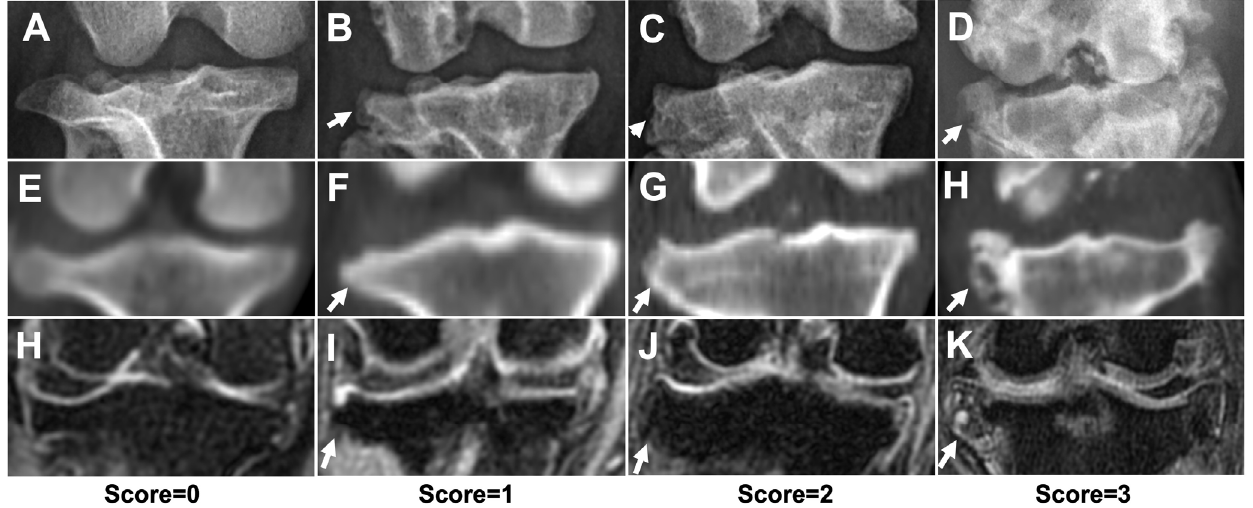
Figure 5. The severity of osteophytes/enthesophytes of stifle joint using different imaging modalities. Representative DR ( A – D ), CT ( E – H ), and MRI ( H – K ) images, with score = 0 ( A , E , H ), score = 1 ( B , F , I ), score = 2 ( C , G , J ), and score = 3 ( D , H , K ). White arrows indicated osteophytes/enthesophytes formation at lateral proximal tibia edges. The score = 0 images were acquired from a dachshund which was not included in this study. Table 3. Comparison of the osteophytes/enthesophytes lesion on DR, CT, and MRI images at different anatomic